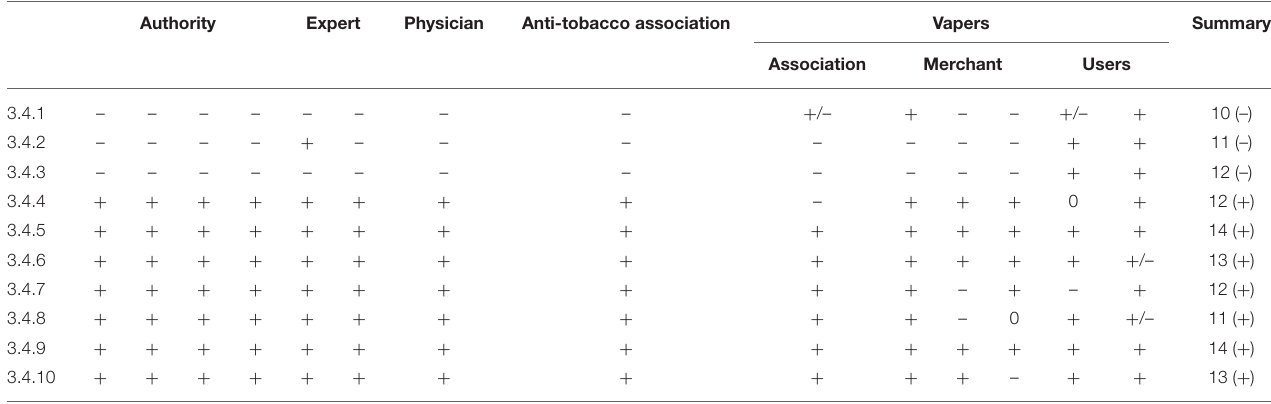
TABLE 2 | Stakeholders’ response to 10 e-cigarette control